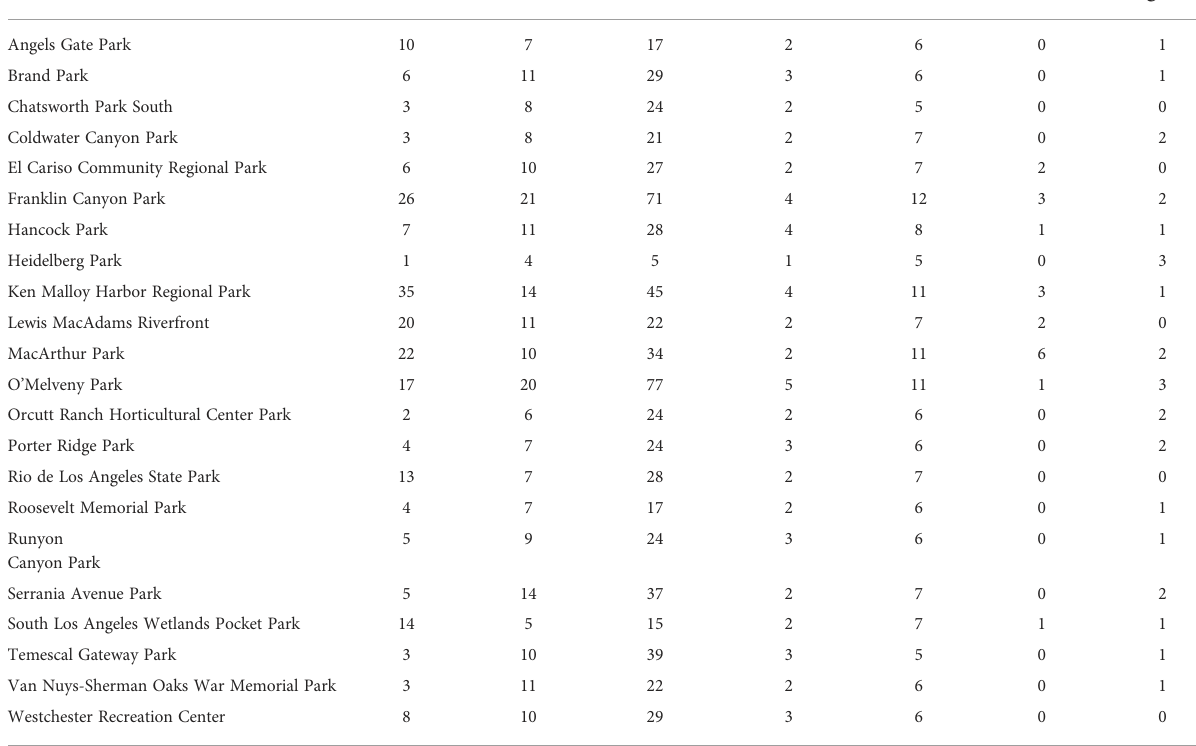
TABLE 3 Avian richness broken down by foraging guild by